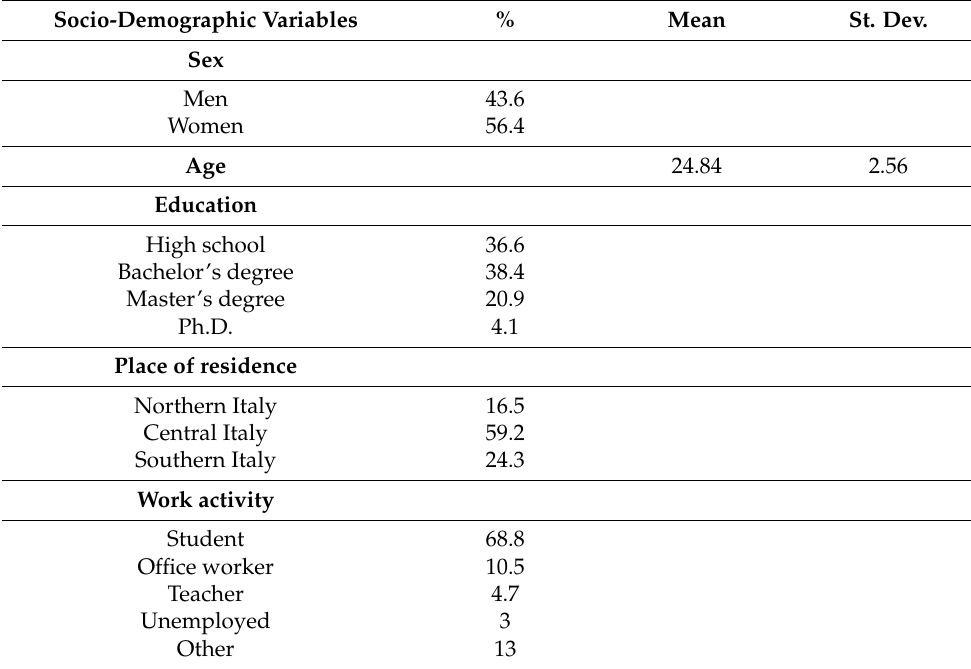
Table 1. Socio-demographic variables of participants. Socio-Demographic